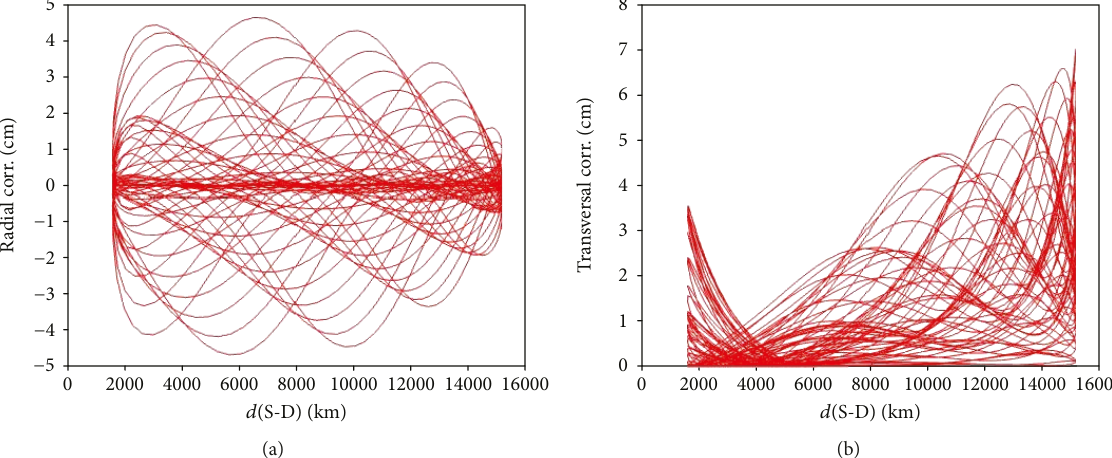
Figure 7: (a) Radial and (b) transverse p-N corrections versus distance from S to D with TOL